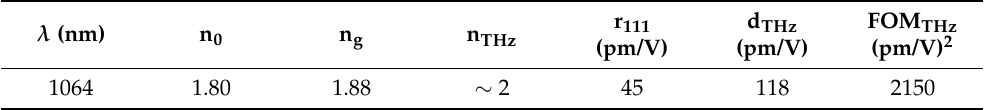
Table 25. Main optical-THz characteristics of BNA.